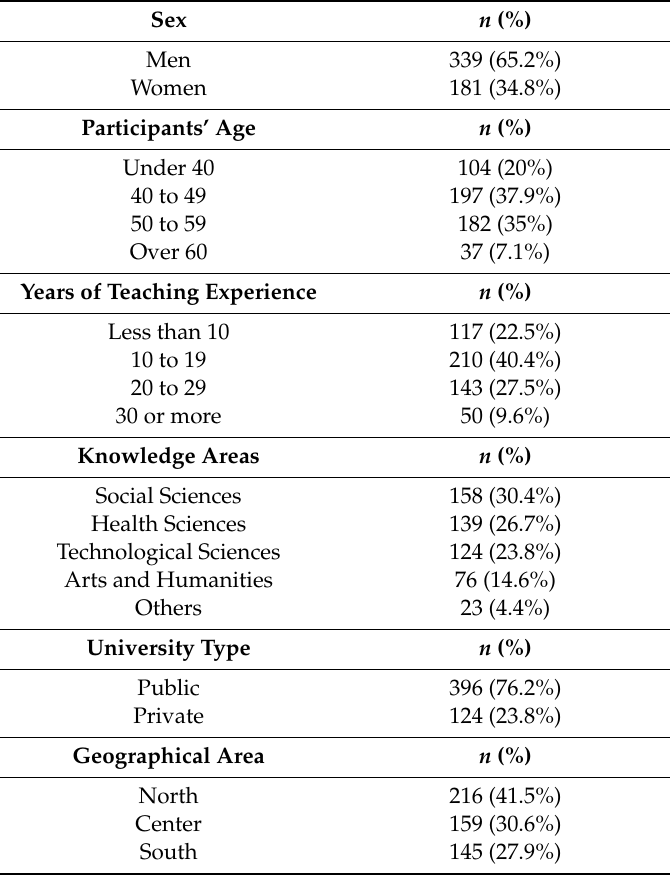
Table 1. Distribution of